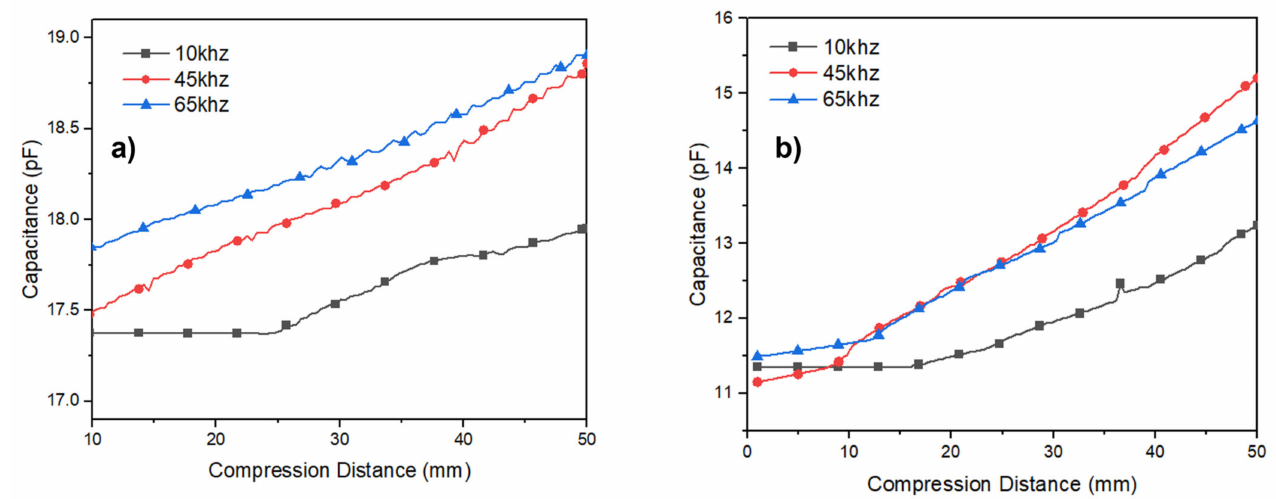
Figure 13. Capacitance changes according to compression distance ( ∆ d p ) , ( a ) NPED, ( b )